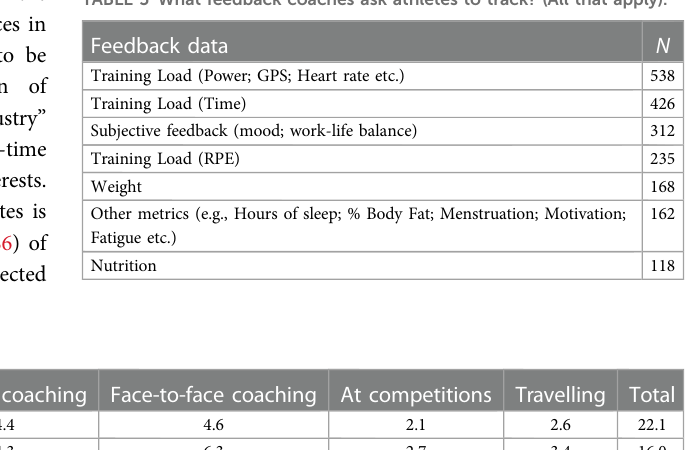
TABLE 5 What feedback coaches ask athletes to track? (All that